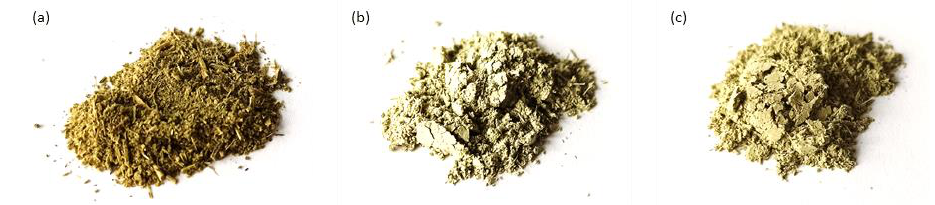
Figure 1. Optical image of ( a ) non-functionalized lavender filler, ( b ) lavender filler functionalized with kaolinite, and ( c ) lavender fillers functionalized with hydroxyapatite.